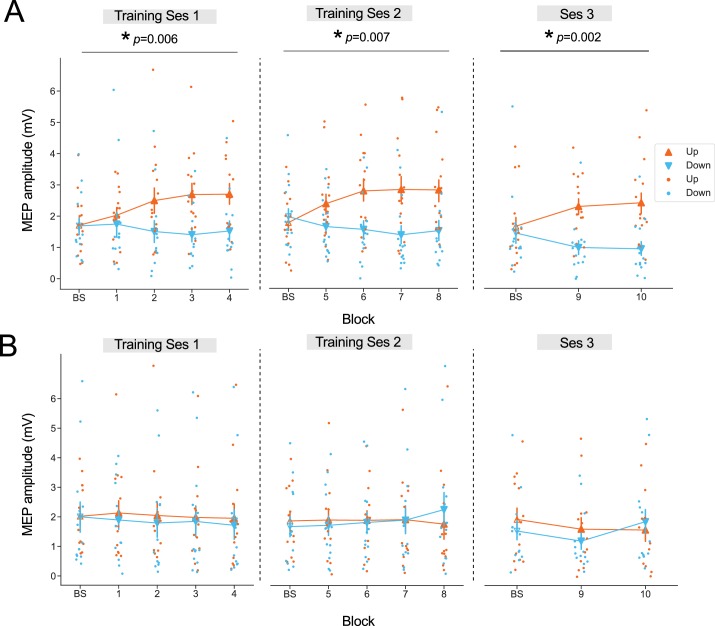
MEP amplitudes during neurofeedback for all participants.Panel A and B in this figure are analogous to Figure 2 in the main manuscript, but here all individual participant datapoints are plotted as dots in line with their means (triangles). Panel A shows MEP amplitude data for the experimental group, and Panel B for the control group, across all training blocks. Means are shown ± SEM.